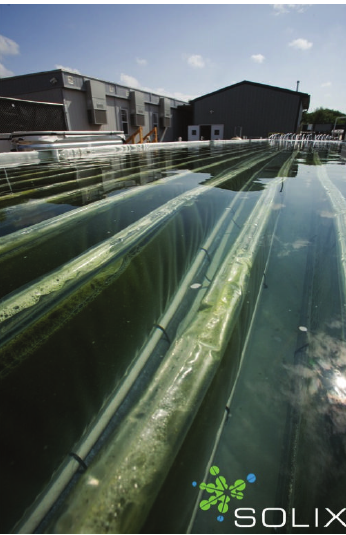
Figure 3: Solix Biofuels demonstration facility: schematic representation of the 3G reactor setup and photography of the production facility [34].